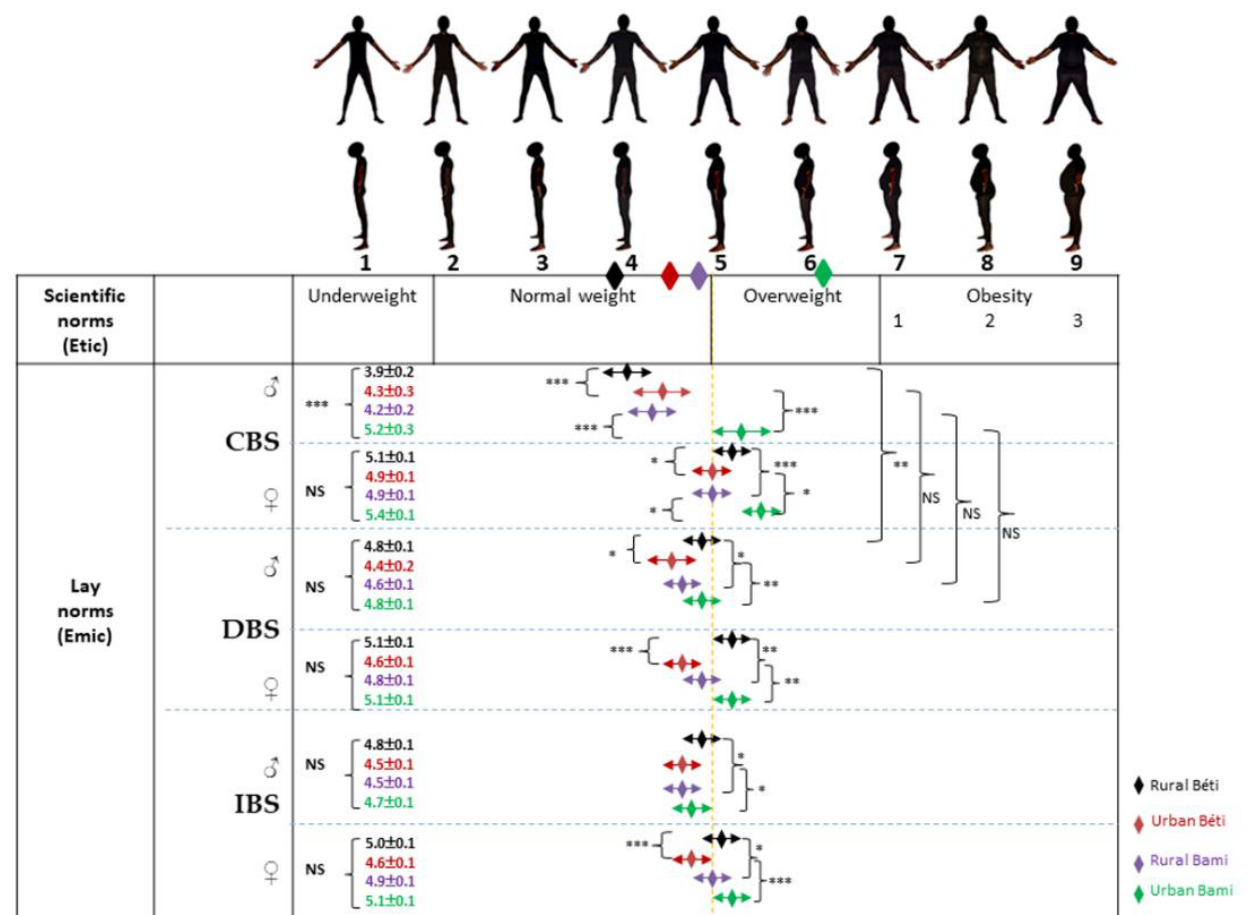
Figure 1. Perceptions of body size on masculine BSS. The diamonds just below the silhouettes correspond to the BMI averages of the four populations (rural Béti, urban Béti, rural Bami, and urban Bami). CBS: current body size; DBS: desired body size; IBS: ideal body size. ANCOVA between the four samples: * p < 0.05; ** p < 0.01; *** p < 0.001. Differences between CBS and DBS were tested using unpaired t -tests, * p < 0.05; ** p < 0.01; *** p < 0.001.